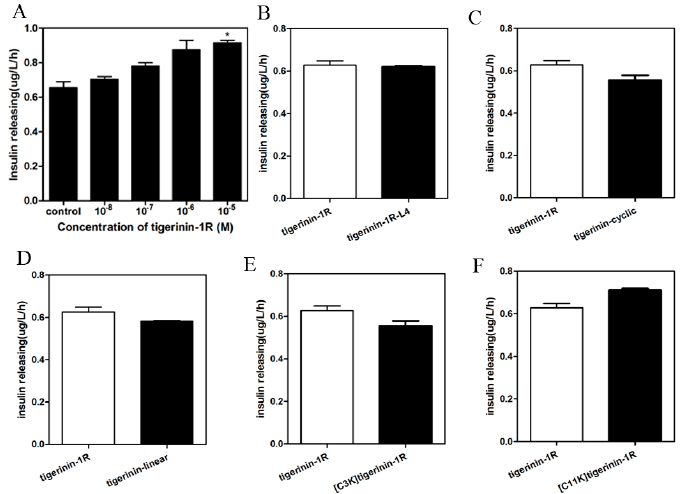
Figure 3. Effect of peptides on the release of insulin from INS-1 cells in the presence of 2.8 mM glucose. ( A ) INS-1 cells were treated with different concentrations of tigerinin-1R in the presence of 2.8 mM glucose (* p < 0.05 compared with glucose alone; n = 3). ( B – F ) INS-1 cells were treated with peptide analogs at a concentration of 10 − 5 M in the presence of 2.8 mM glucose. The assays were repeated in triplicate.